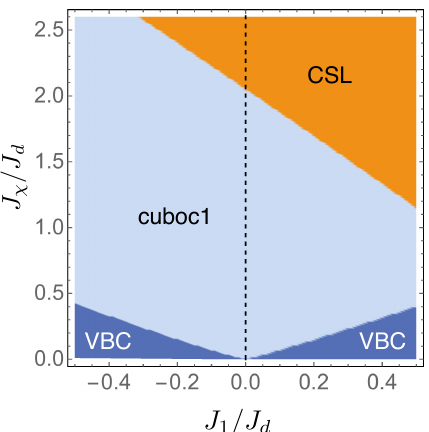
Figure 3: Ground state phase diagram obtained from the perturbative renormalization group approach. The CSL region corresponds to the gapless chiral spin liquid phase and VBC to the valence bond